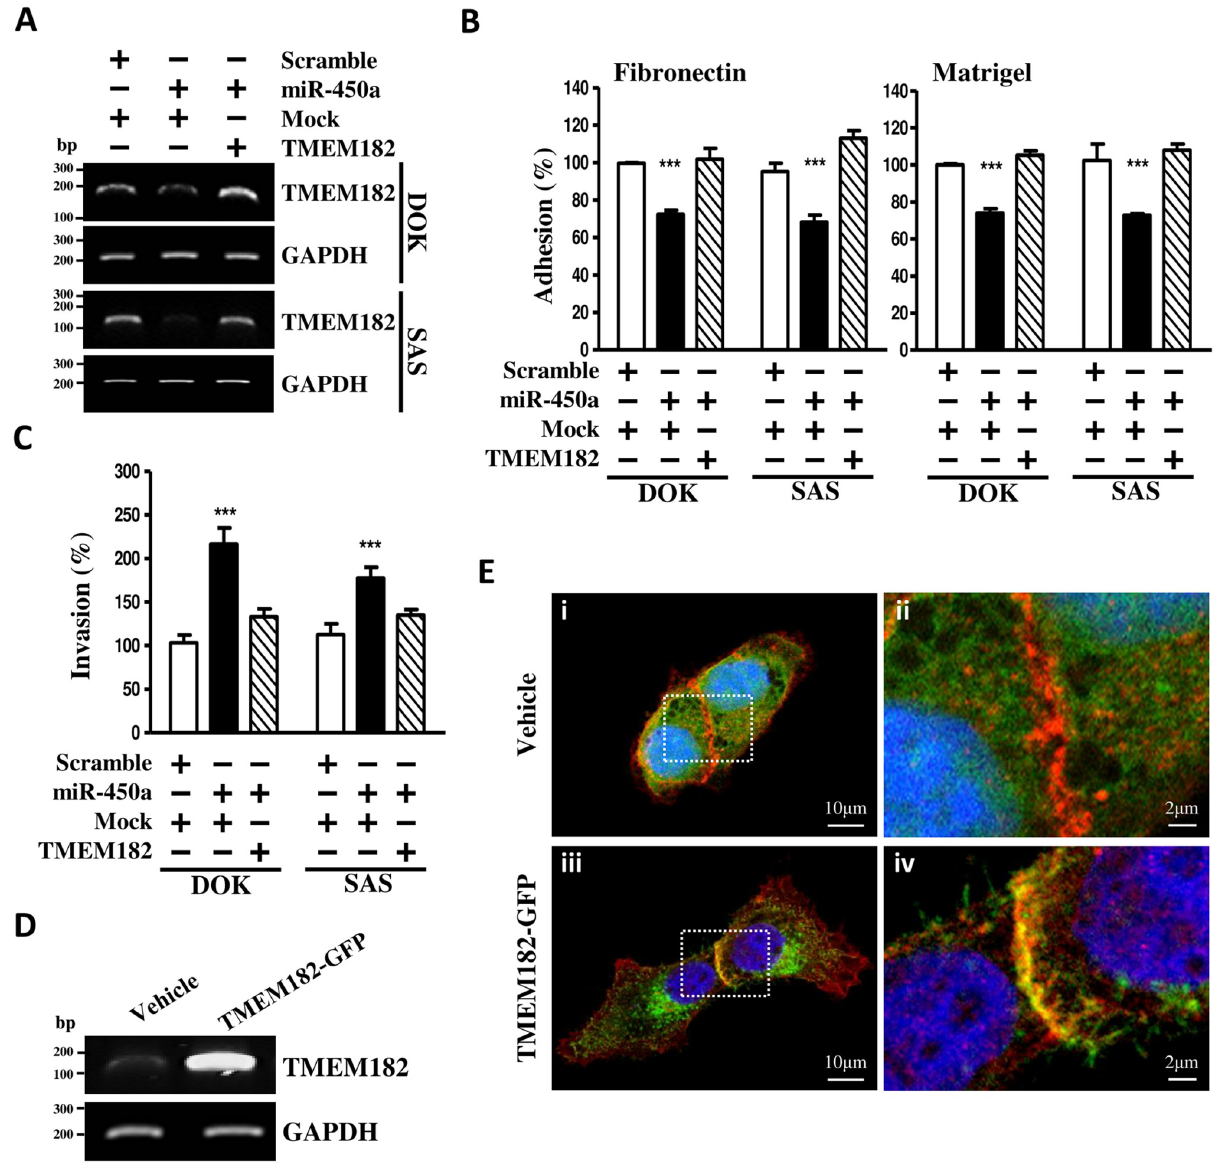
Fig 4. Overexpression of TMEM182 renders human OSCC cells resistance to miR-450a-decreased cell adhesion. (A) Changes of TMEM182 levels in OSCC cells transfected with control miRNA (scramble)/miR-450a and pCDH-CMV-GFP puro+ (vehicle)/TMEM182 (TMEM182-flag) were assessed by RT-PCR as described in panel. GAPDH was used as a loading control. (B) Cell adhesion assays of OSCC cells transfected with scramble/miR-450a and vehicle/TMEM182-flag were as described above. (C) Transwell invasion assays were used to measure the effect of scramble/miR-450a and vehicle/ TMEM182-flag in DOK and SAS cells after 48 hrs transfection. (D) TMEM182 overexpression in SAS cells was confirmed with RT-PCR after transfection of GFP-linked TMEM182 (TMEM182-GFP) and empty vector pEGFPN1 (vehicle). (E) Representative epifluorescence images of SAS cells transiently transfected with TMEM182-GFP/ Vehicle and co-immunolabeled endogenous E-cadherin. Vehicle (Green) expression was scattered inside of cells (D-i, D-ii) . Co-stained E-cadherin (Red), as a plasma membrane marker, was localized at the lateral membrane and intracellular junctional area. Nuclei were labeled with DAPI (Blue).TMEM182-driven GFP(green) was co-localized with E-cadherin (red) at the sites of cell-cell contact on the plasma membrane (D-iii, D-iv) . Original magnification, x400. Data was represented as mean ± SEM; � P < 0.05, �� P < 0.01, ��� P < 0.001.